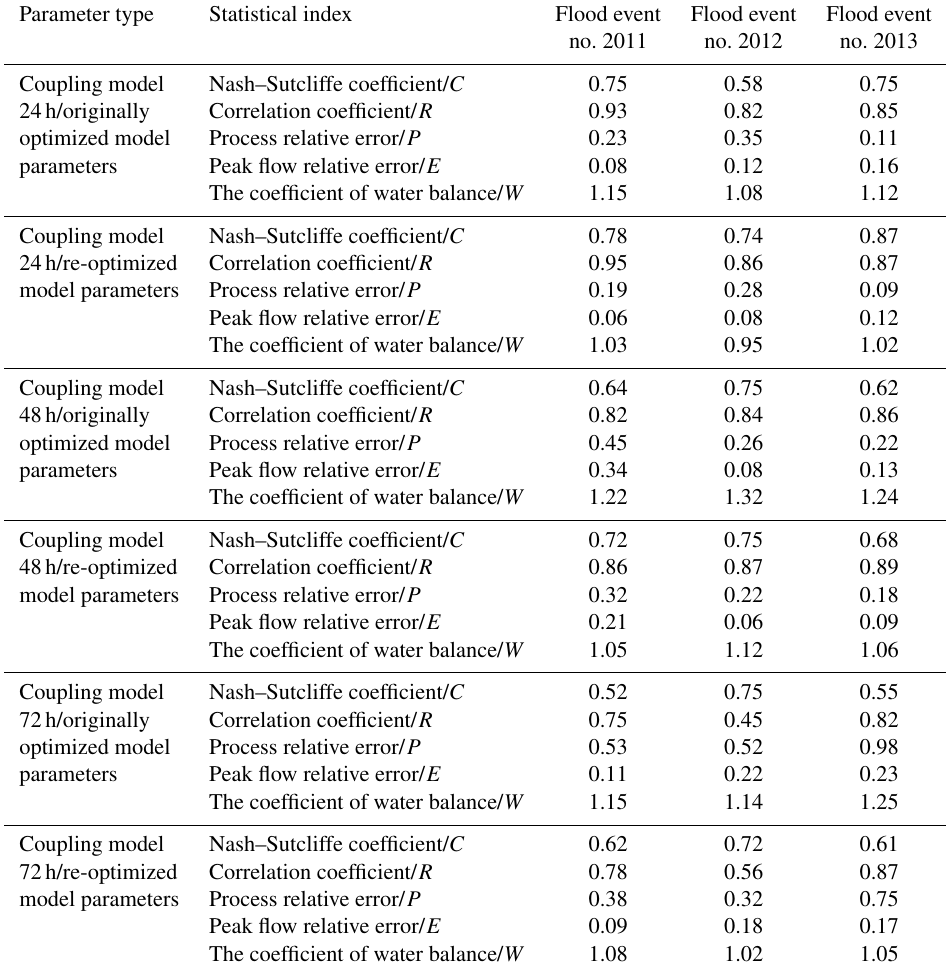
Table 3. Evaluation indices of simulated flood events with different model